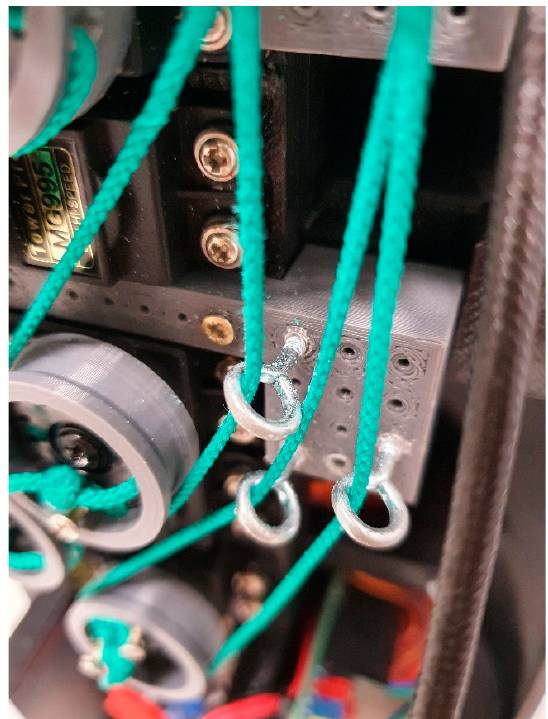
Figure 11. Tensioning system of traction wires.